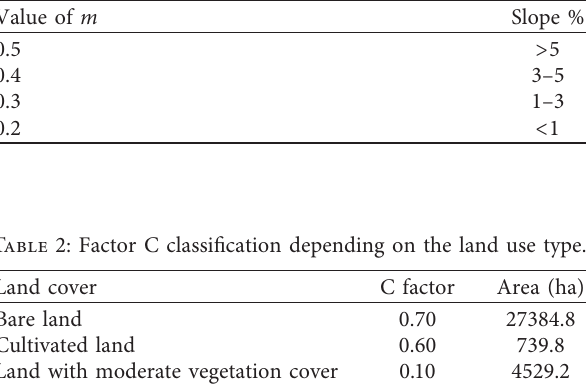
Table 1: Variation of m depending on slope value.